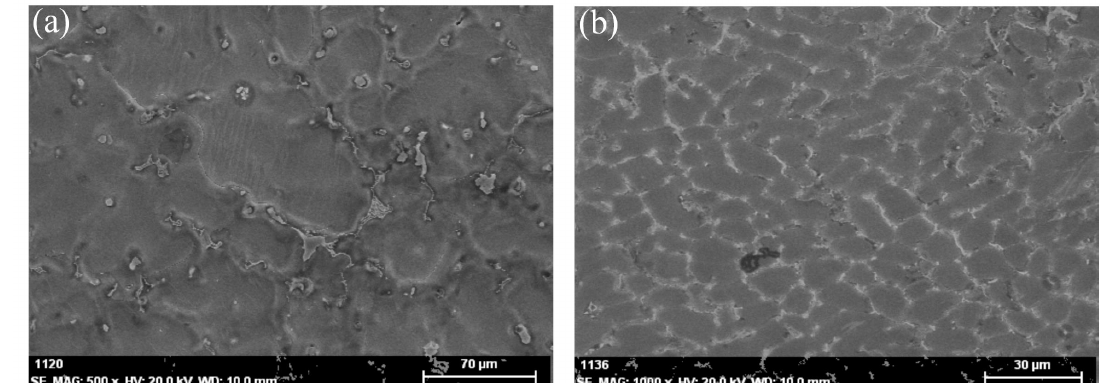
Fig. 1. Microstructure of Mg-4.5Al-1.0Zn Mg alloy: (a) Ingot and (b)